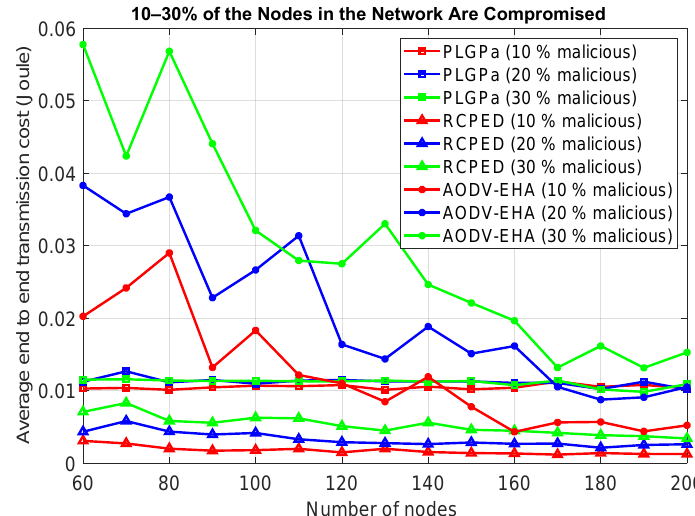
Figure 7. Average end to end overall transmission cost